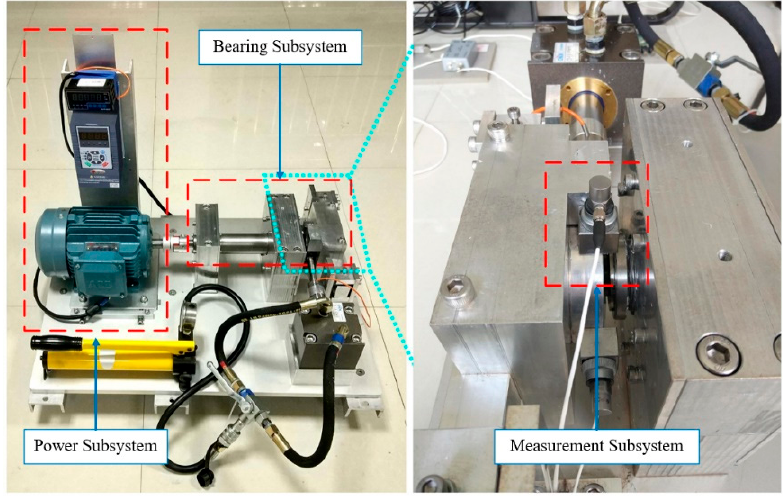
Figure 3. The experimental platform of XJUT-SY.